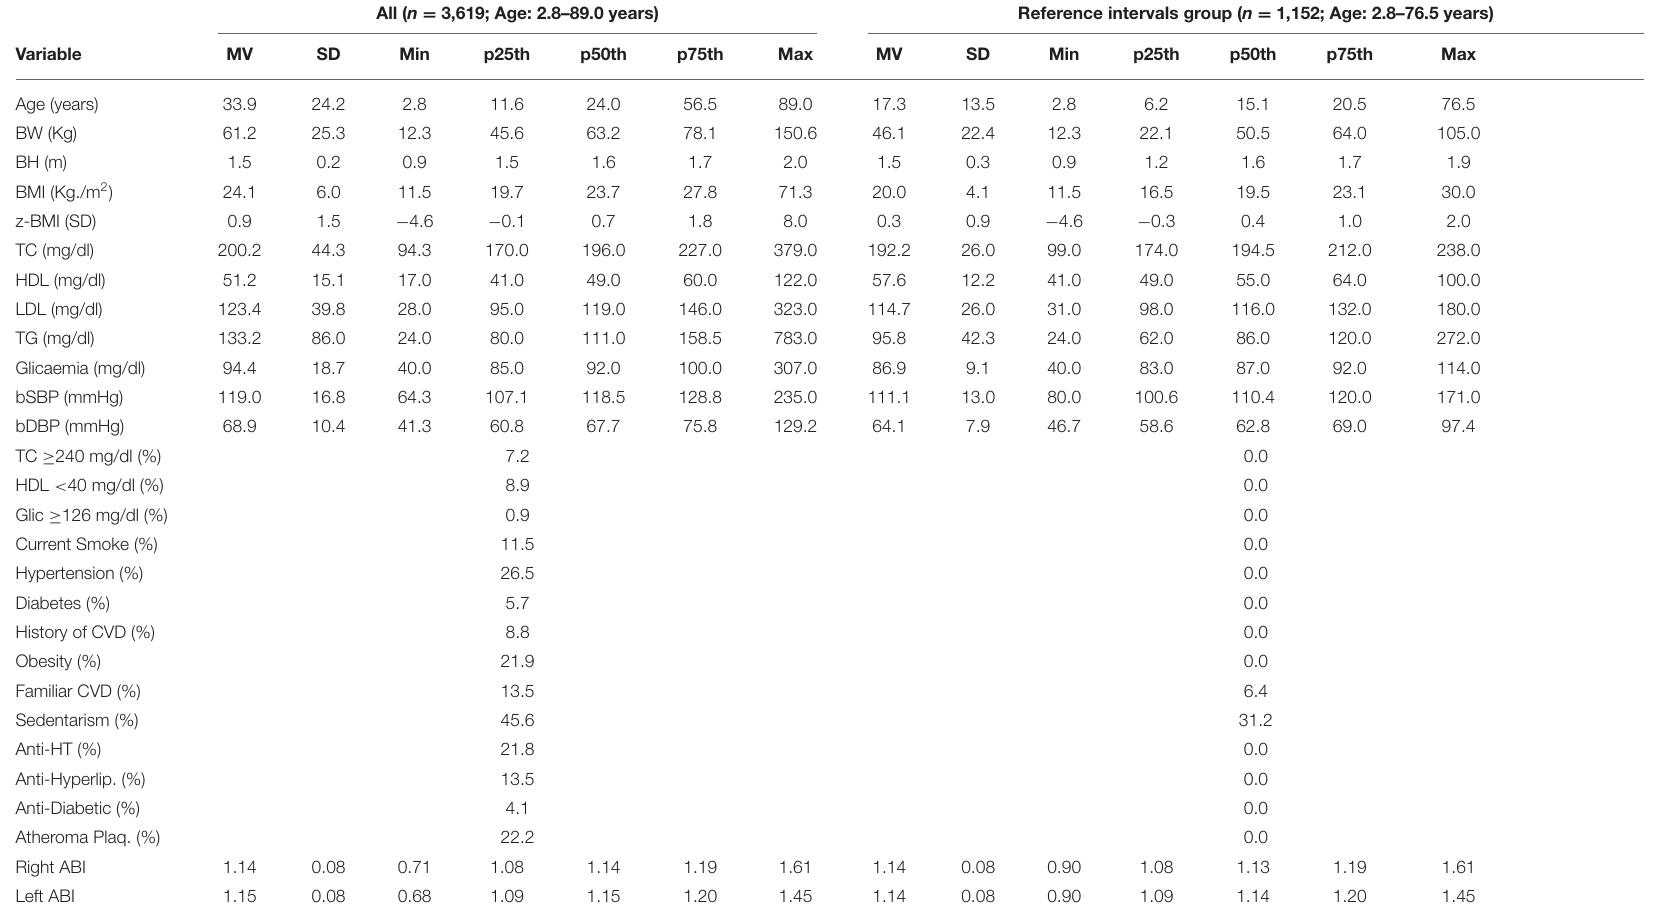
TABLE 2 | Demographic, anthropometric, and clinical characteristics of